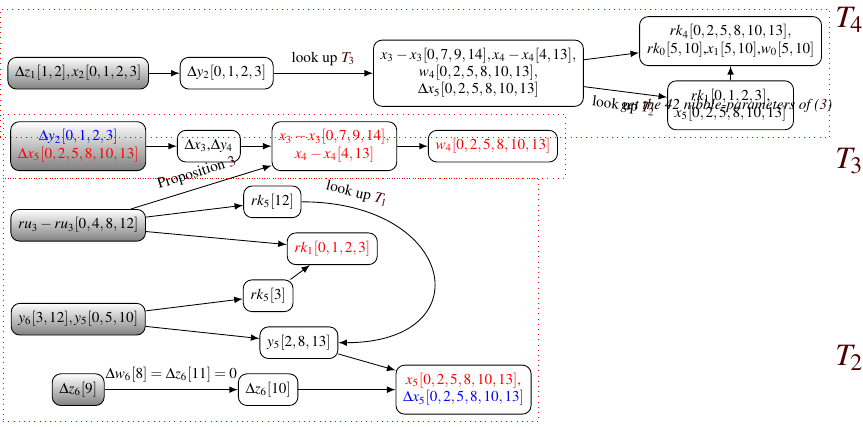
Figure 8: Constructions of Table T 2 , Table T 3 and Table T 4 on the 10-round attack. For T 2 , there are about 2 8 values for each index in average. For T 3 , there are about 2 24 values for each index in